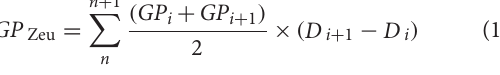
( Figure 8 ), F v /F m , F inverse relationship to light availability during high excitation pressure (PAR > 300 µ mol quanta m − 2 s − 1 , Figure 4B